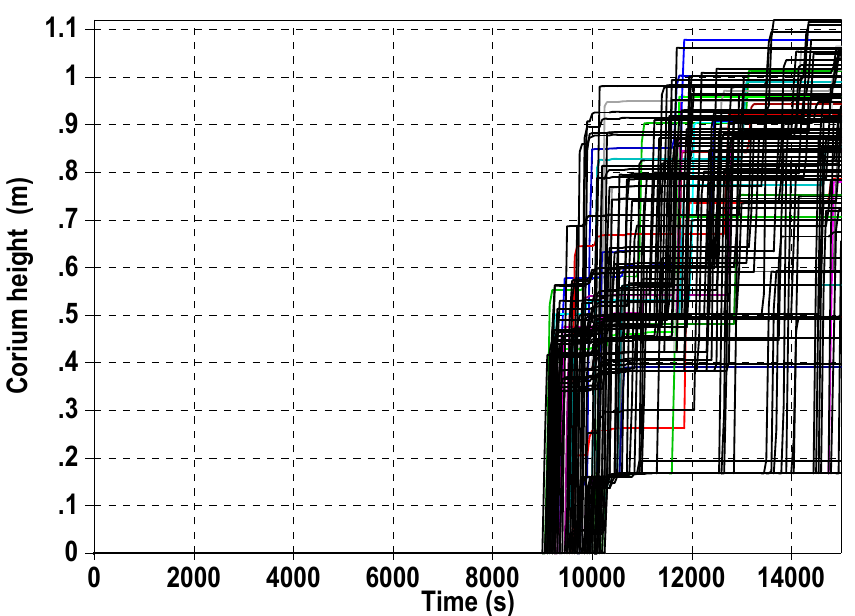
Figure 8. Radius of the in-core molten pool.